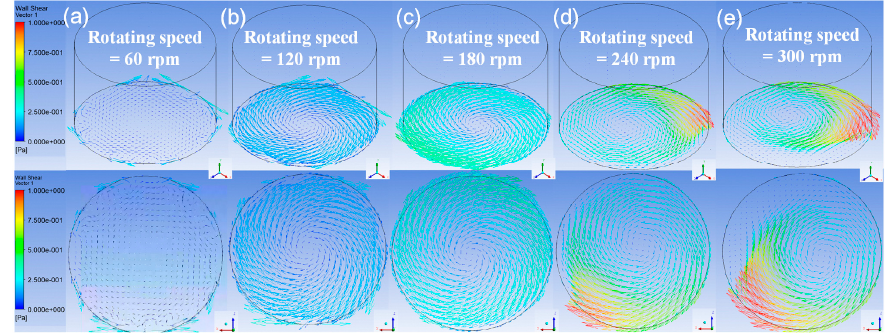
Figure 8. The isometric view and top view of the shear stress distribution on the bottom surface of the container. The shaker’s rotational diameter is fixed at 1 cm and the rotational speed is adjusted to ( a ) 60 rpm, ( b ) 120 rpm, ( c ) 180 rpm, ( d ) 240 rpm, and ( e ) 300 rpm respectively from left to right. The coordinate is X ’ YZ ’ system. (Container’s diameter = 3 cm)